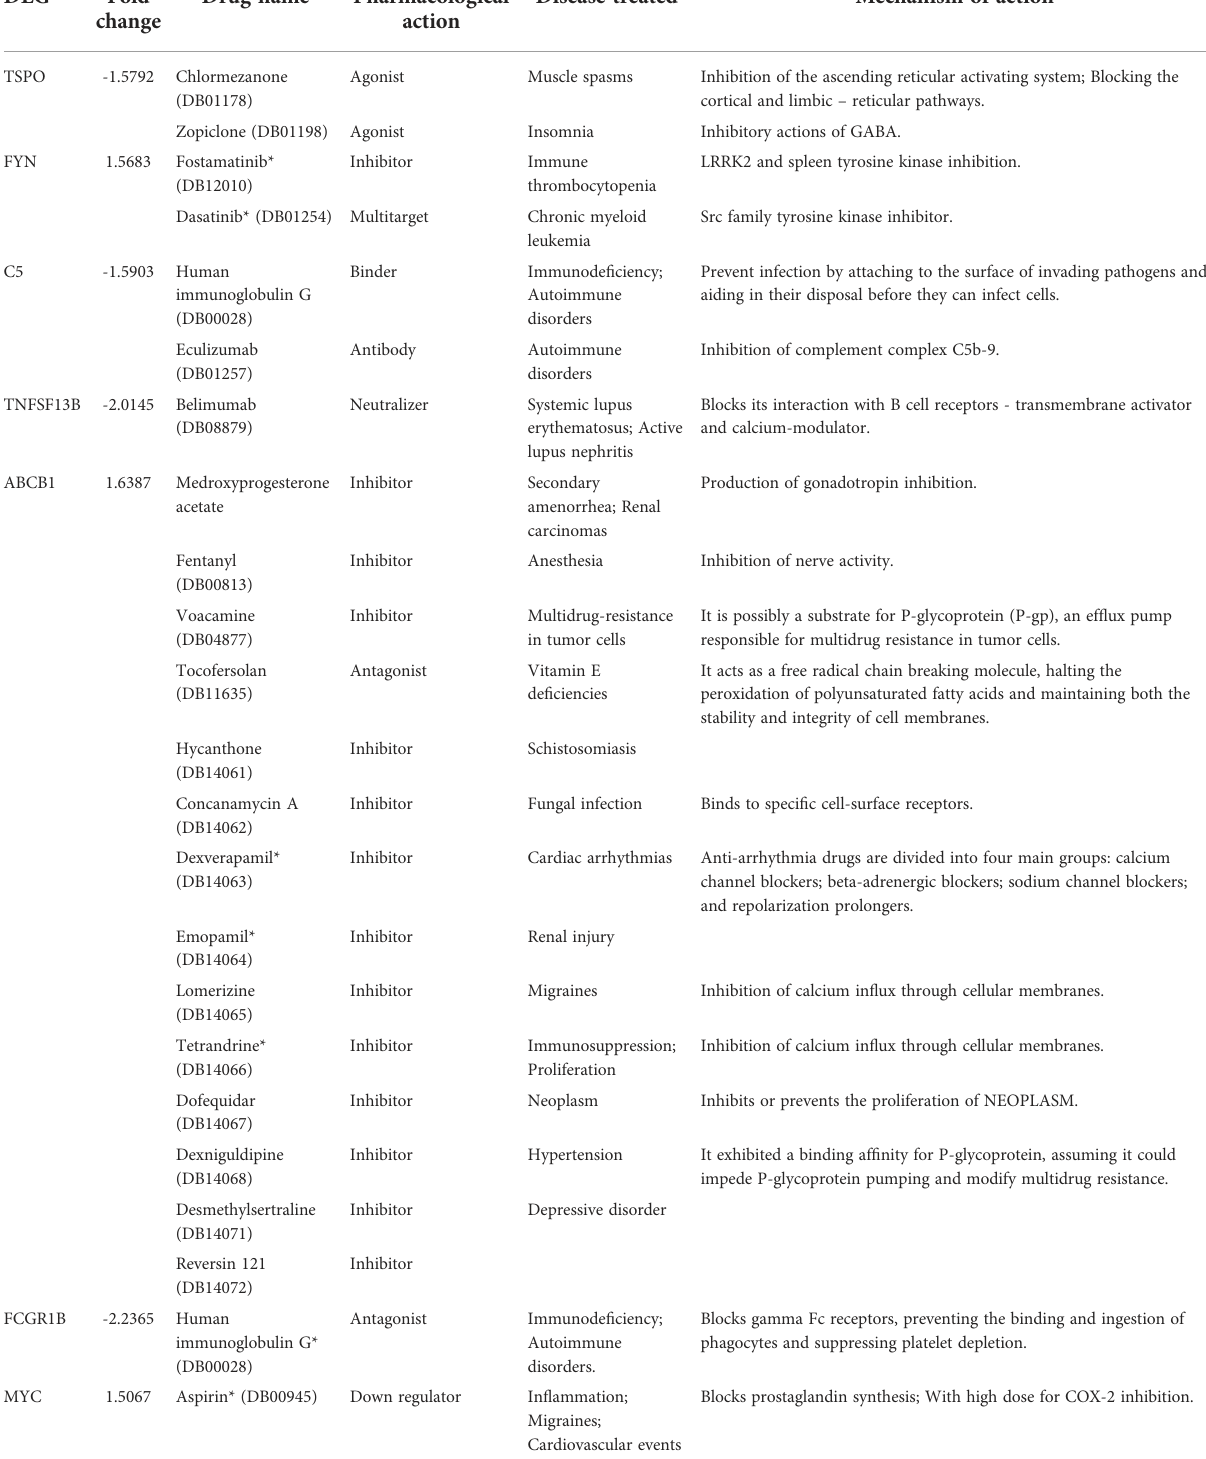
TABLE 5 List of drugs in DrugBank targeting DEGs in the